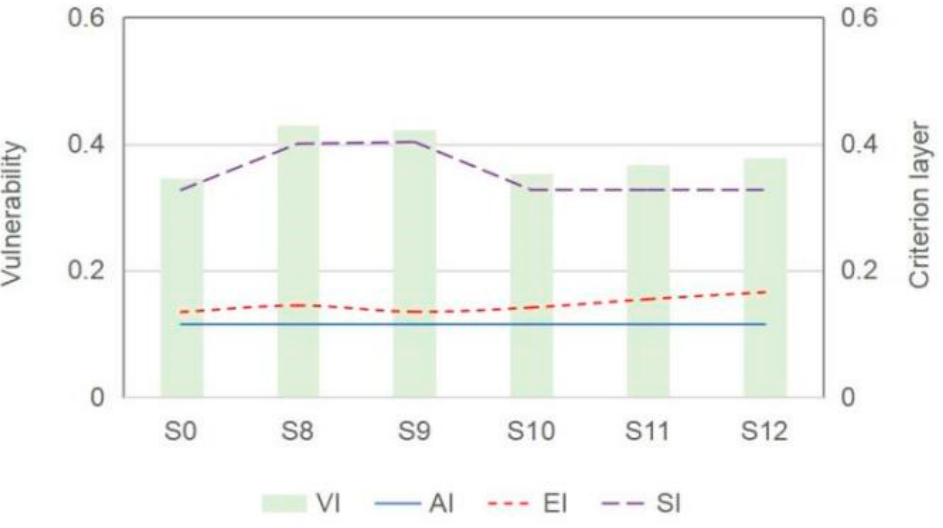
Figure 10. The vulnerability of resources (WEF) under S0 and S8 to S12.